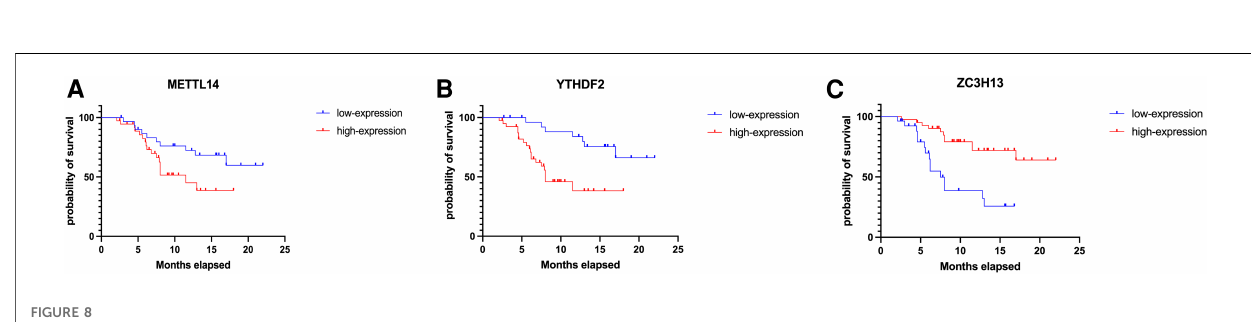
FIGURE 8 Kaplan – Meier-plotter results of METTL14, YTHDF2, ZC3H13 ( A – C